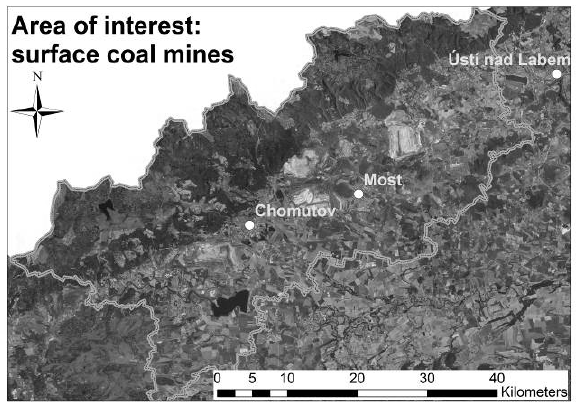
Figure 1. The area of interest, an area of surface coal mines in the northwestern region of the Czech